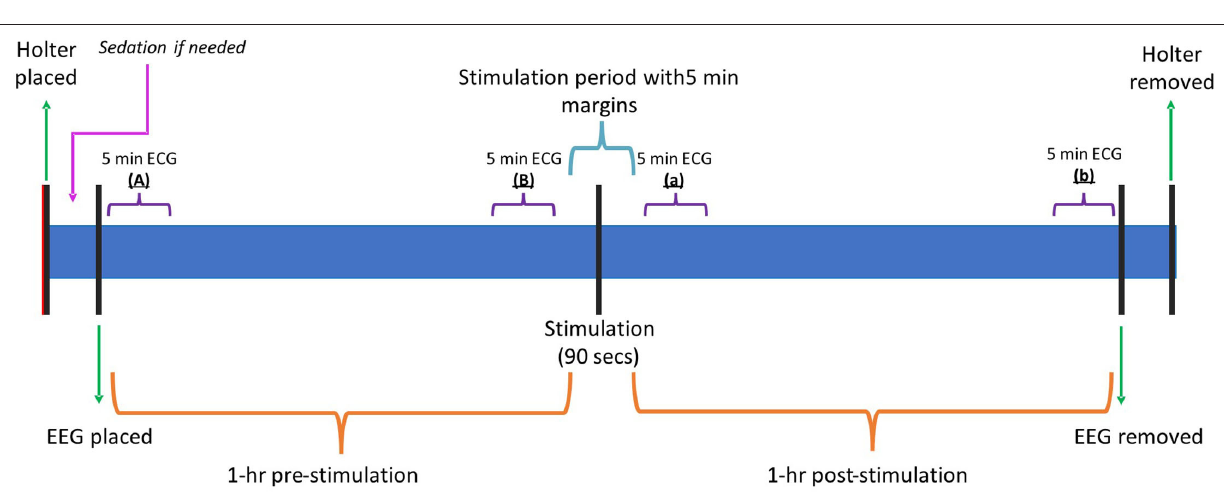
Frontiers in Veterinary Science |